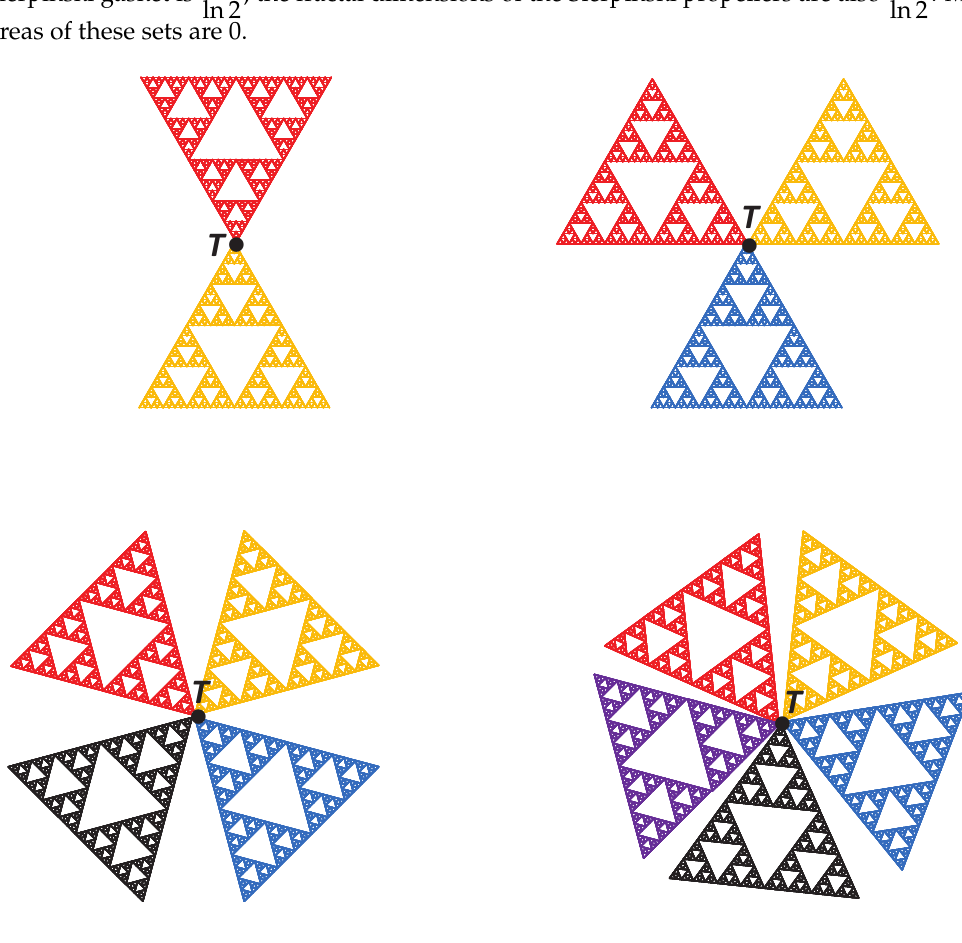
Figure 2. The classical Sierpinski